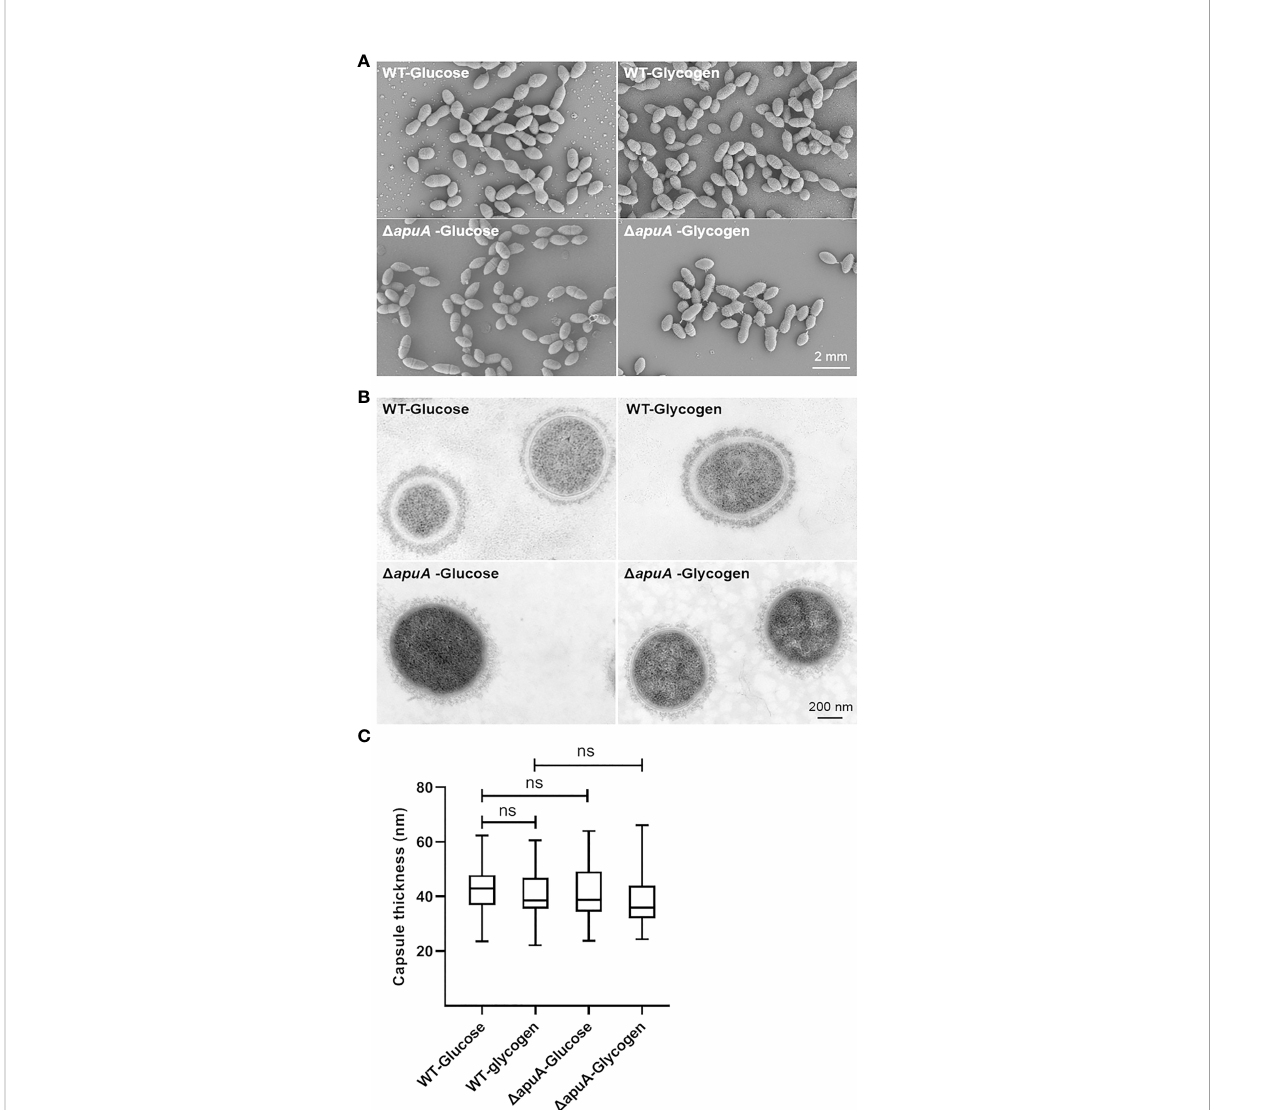
FIGURE 6 Bacterial morphology characterization of WT and D apuA in the presence of different media. (A) Scanning electron micrographs. (B) Transmission electron micrographs. (C) Comparative analysis of capsule thickness. Data are presented as box-and-whisker plot (minimum to maximum). Statistical analyses were performed via unpaired Student ’ s t tests (ns, P >